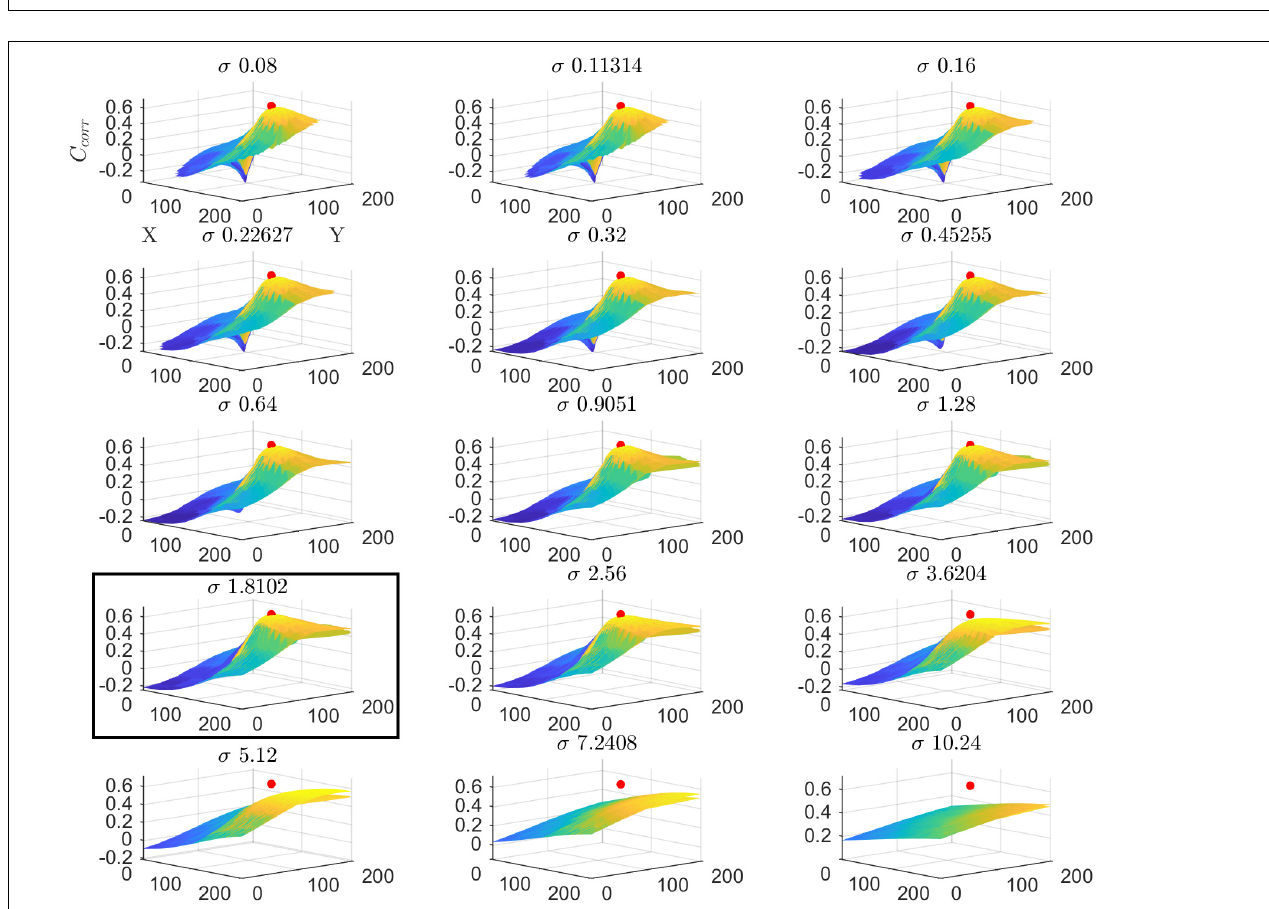
FIGURE 4 | Cost function (C corr ) in the space of the pRF paramters ( x , y , σ ) for a voxel from the HCP dataset in the first split of the data (subject code 100610, first split, voxel index 5). The location of the global maximum is represented by a red dot and is obtained σ = 1 . 81. Each subplot represents the cost function at varying values of µ (defined by ( x , y ) ) while the different subplots are obtained varying the value of the pRF size ( σ ). For visualization clarity in this figure we used cartesian coordinates instead of eccentricity and